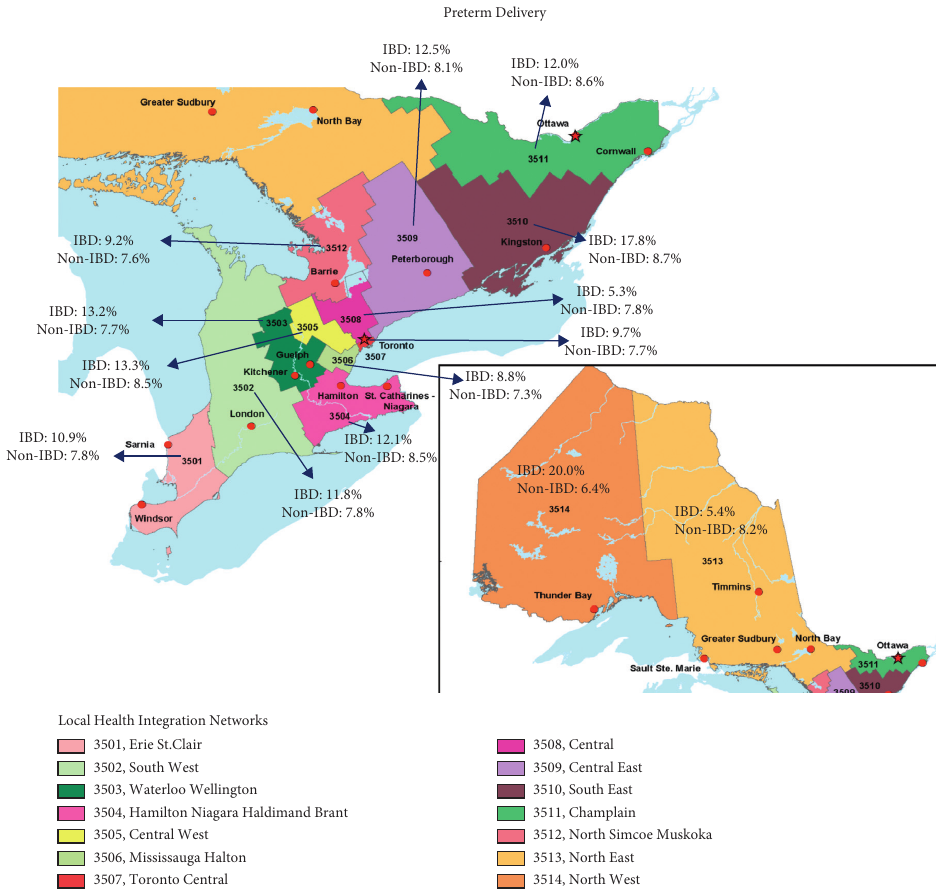
Figure 1: Incidences of preterm delivery in women with and without inflammatory bowel disease (IBD) across the 14 Local Health Integration Networks in Ontario. Table 3: Age-adjusted odds ratios for preterm birth stratified by Local Health Integration